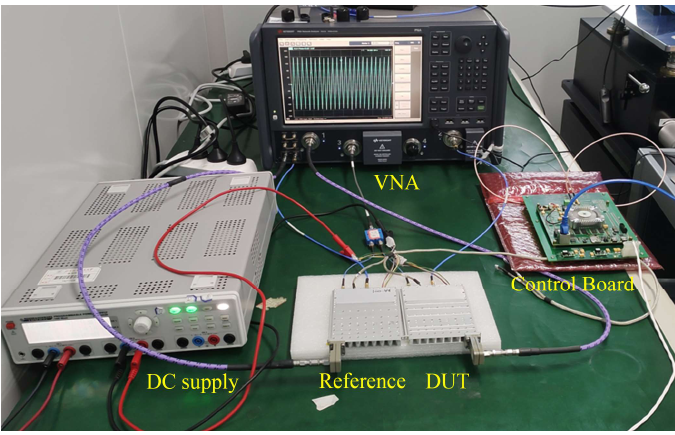
Figure 22. The channel phase error measuring platform..